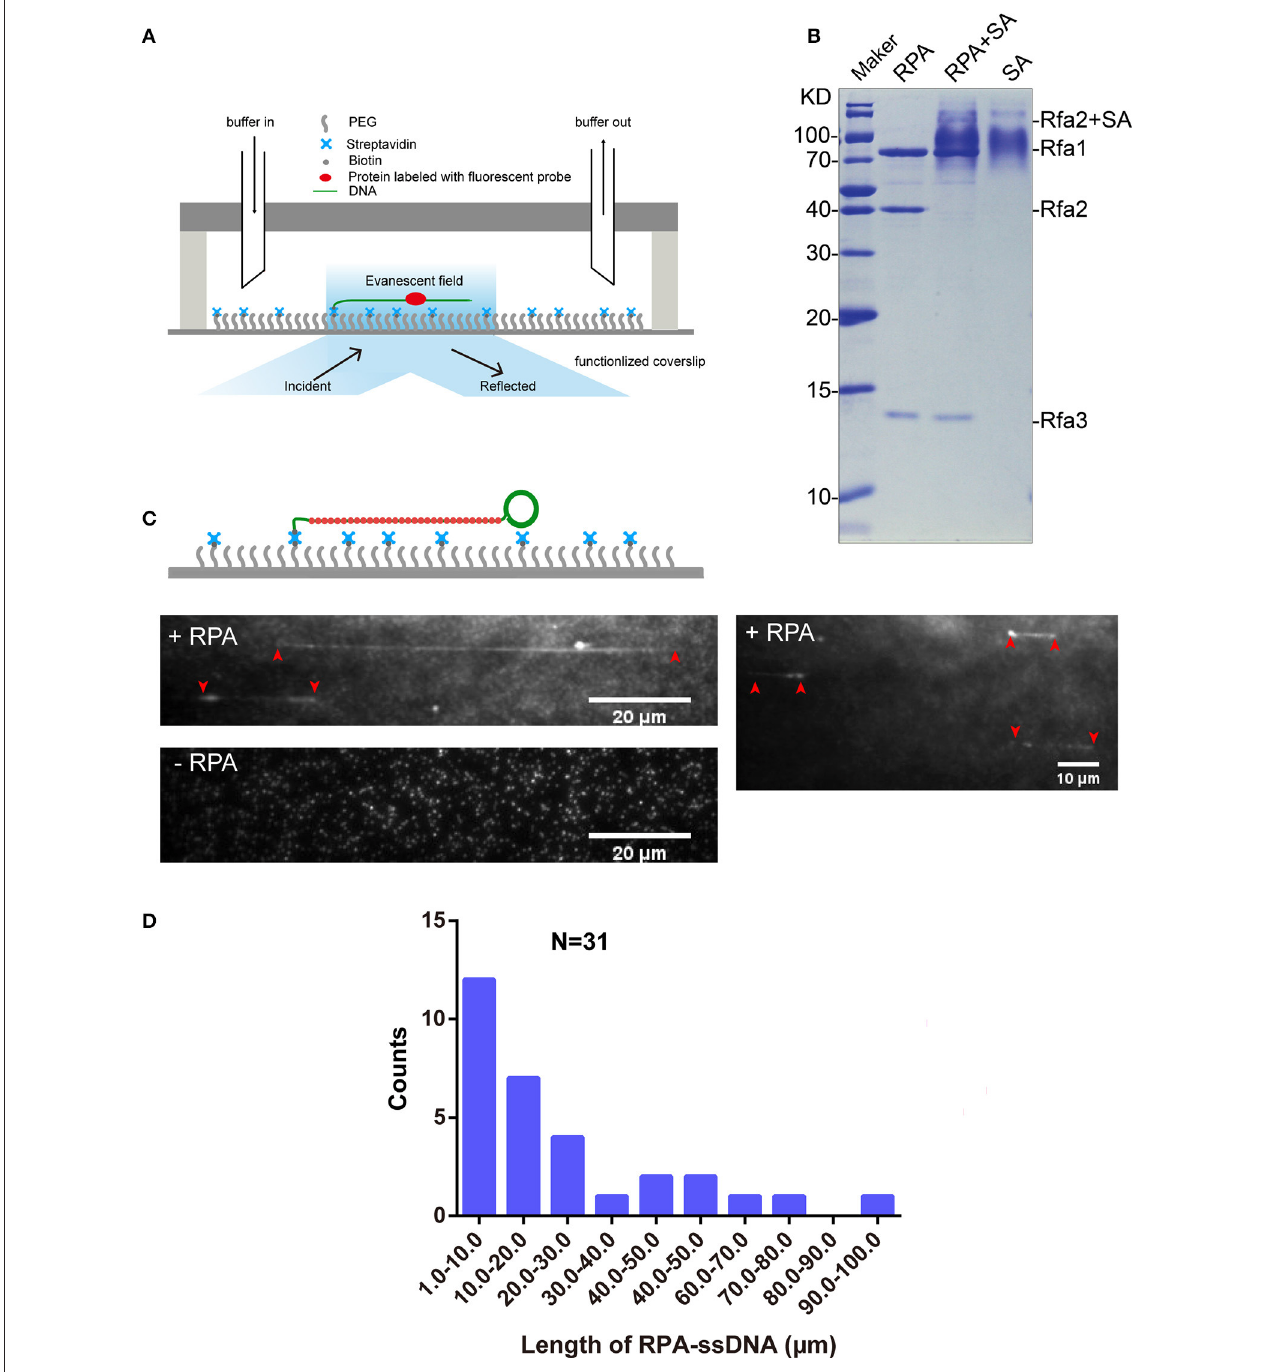
FIGURE 3 | RPA purification and single-molecule visualization. (A) Single-molecule experiment platform. DNA was tethered on the coverslip through a biotin–streptavidin linkage. A protein bound on DNA is illustrated. Flow is from left to right. (B) Purified RPA and its biotinylation extent evaluation. Purified RPA (lane 1); RPA + unboiled streptavidin (SA) (lane 2); unboiled streptavidin (lane 3). Purified biotinylated-Rfa2 was shifted almost completely in the presence of streptavidin. (C) Illustration of streptavidin-coated-Qdot 705 labeled RPA (RPA-Qdot 705 , red) binding on and stretching ssDNA (green), together with flow (top), 0.1nM RPA-Qdot 705 was pumped into flow cell (middle). 0.1nM streptavidin-coated-Qdot 705 was pumped into flow cell (bottom). Red arrows point out the two ends of RPA-ssDNA. (D) Length of ssDNA bound with RPA.